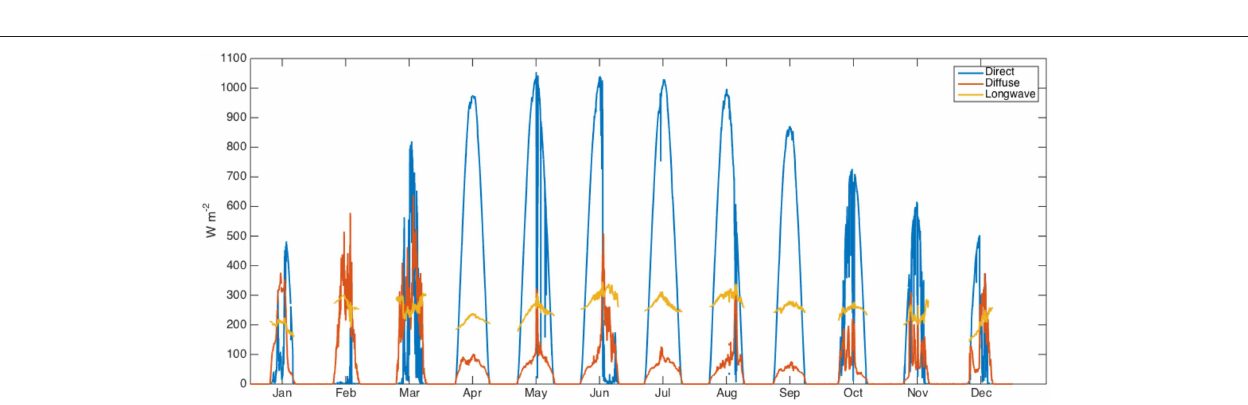
FIGURE 7 | Monthly high and low temps at CUES 1992–2014. Missing values were filled with data from nearby sensors at similar elevations.